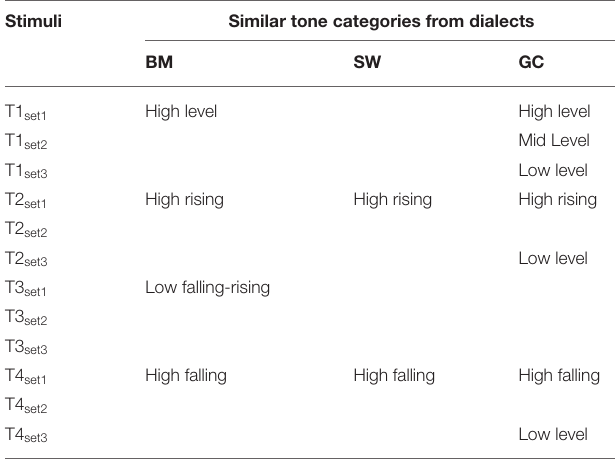
TABLE 3 | Tone categories from the three dialects similar to the present tone